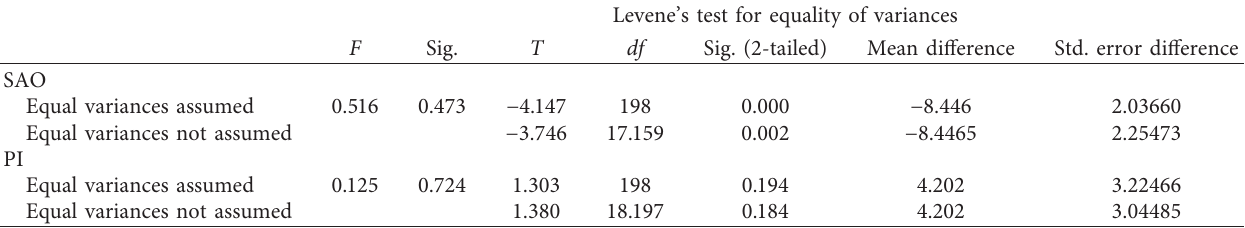
Table 2: Student t -test and Levene’s test for SAO and PI between control and spondylolisthesis groups.